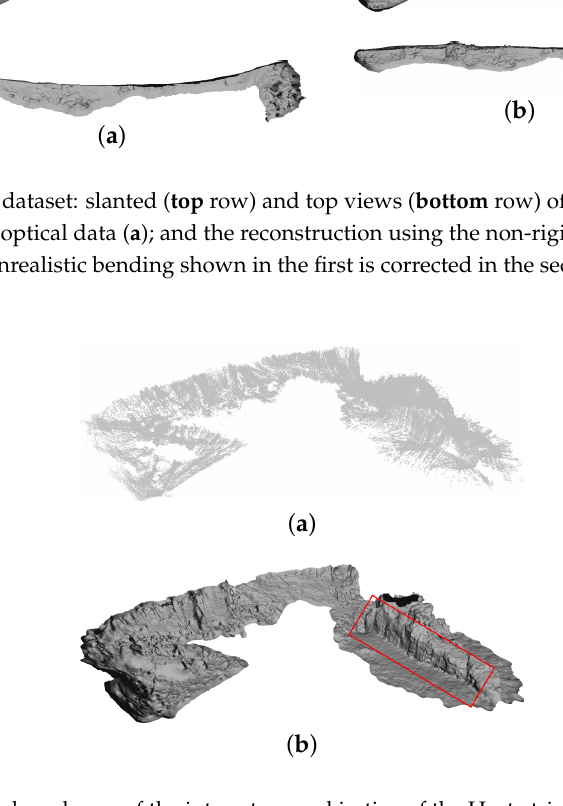
Figure 7. Multibeam-based map of the interest area, objective of the Horta trials 2015, built prior to the experiments. The raw point set in ( a ) was used to build the surface model in ( b ). The marker shows the natural vertical structure, main target of the experiments in Horta for the Morph